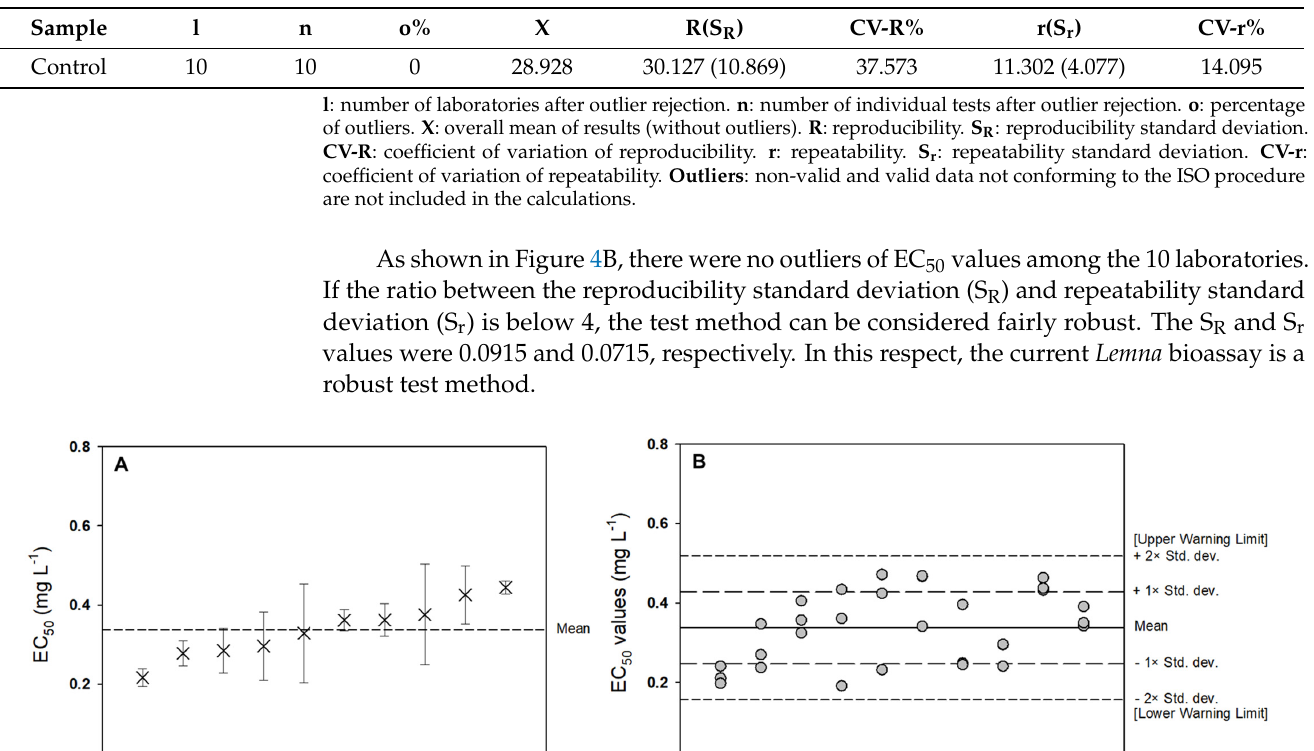
Figure 3. ( A ) Mean root length ± standard deviation of control samples from 10 laboratories. ( B ) Graphical representation of the warning chart approach to the control root lengths of Lemna minor from 10 laboratories. Table 5. Summary of interlaboratory test results based on control root length (mm) of Lemna toxicity test.